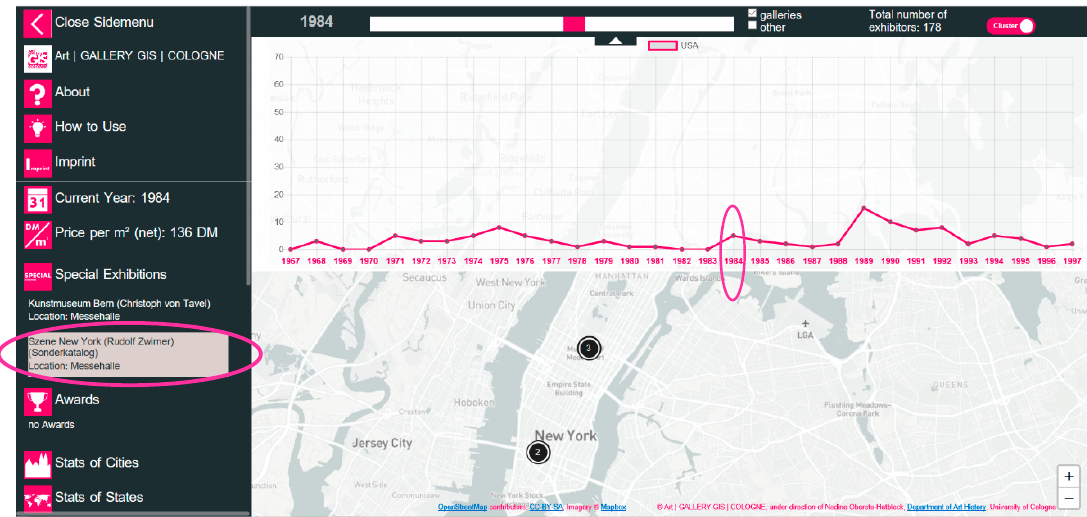
Figure 6. Line diagram for the number of galleries, art dealerships, and publishers of limited editions from the USA who participated in Kunstmarkt Köln->ART COLOGNE 1967–1997, combined with information about special exhibitions at Kunstmarkt Köln->ART COLOGNE in 1984. Used by permission. © ART|GALLERY GIS|COLOGNE [emphasis in the map added].